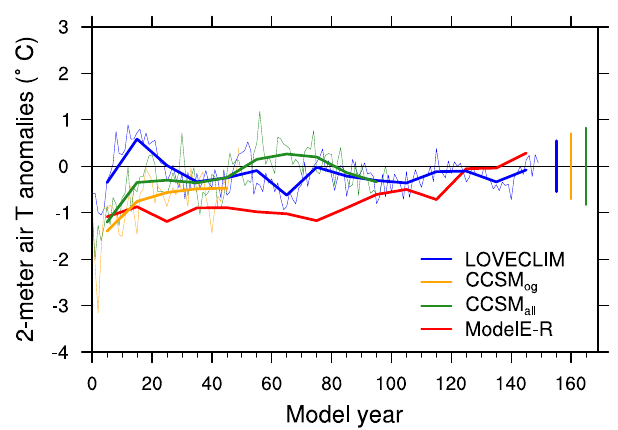
Fig. 9. Time series of annual-mean surface air temperature aver- aged over the region 50–70 ◦ N, 60 ◦ W–10 ◦ E in the North Atlantic, expressed as anomalies in degrees Celsius from the long-term con- trol average. The MWP of 2.5Sv for one year was added at Model year 1. Vertical lines on the right show the 2-sigma range of inter- annual variability in the control simulations, and are not shown for ModelE-R since only 30-yr control averages are